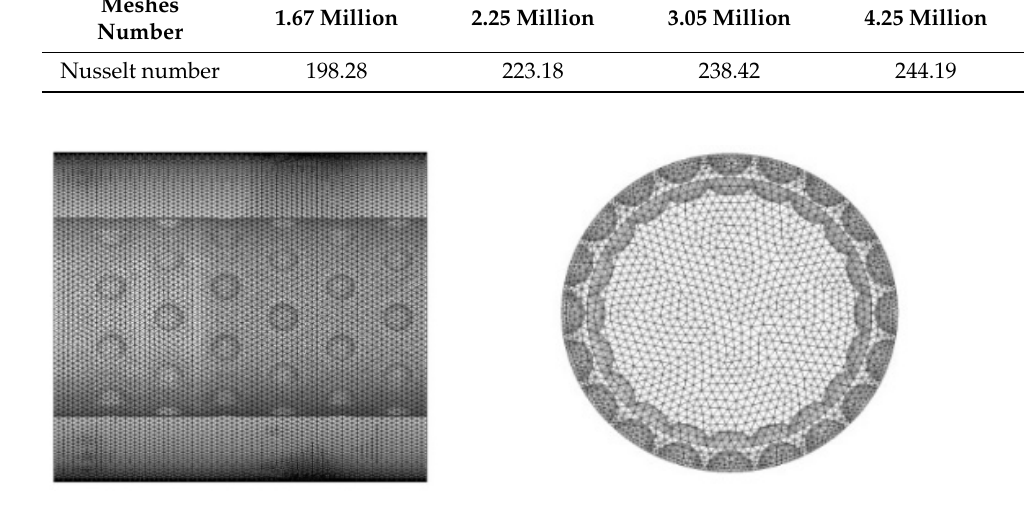
Figure 2. Computational grid.